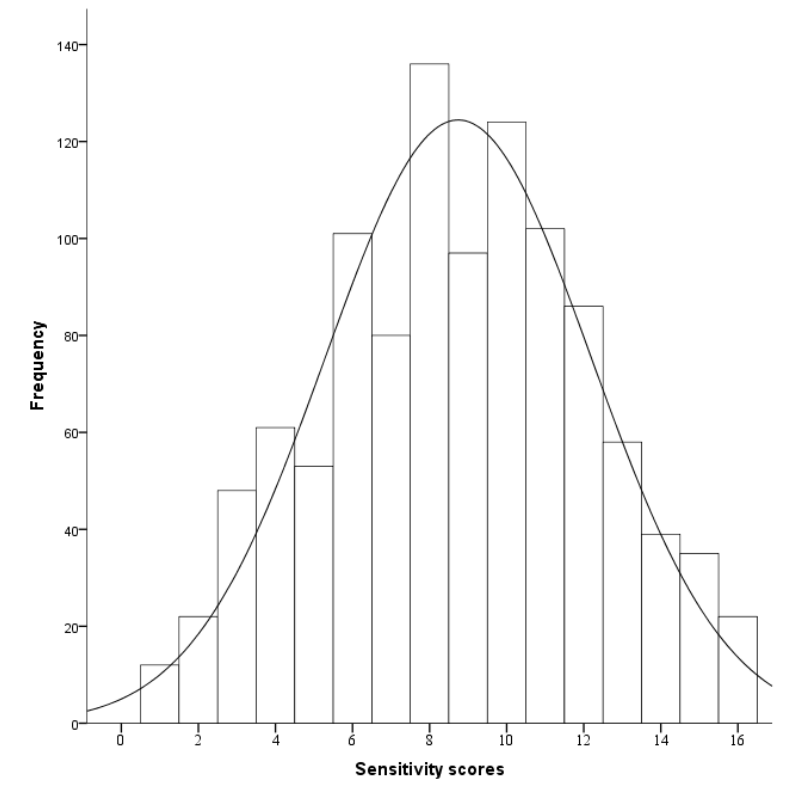
Figure 1. Distribution of noise sensitivity scores in the study population (the solid line indicates the Gaussian